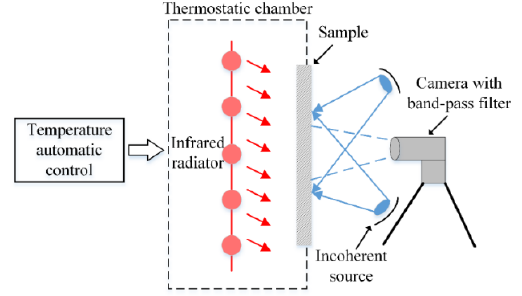
Figure 2. Strain measurement configuration with blue light source, redrawn from [24].